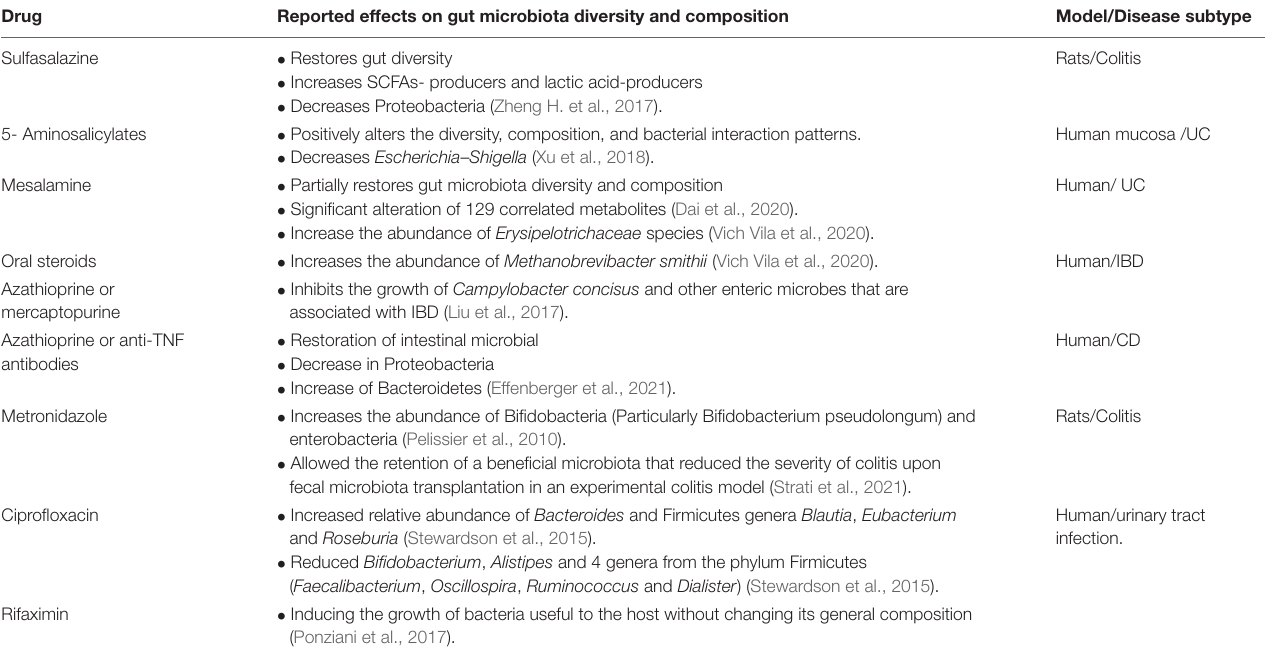
TABLE 2 | The effect of medications used for treatment of IBD on gut microbiota. Drug Reported effects on gut microbiota diversity and